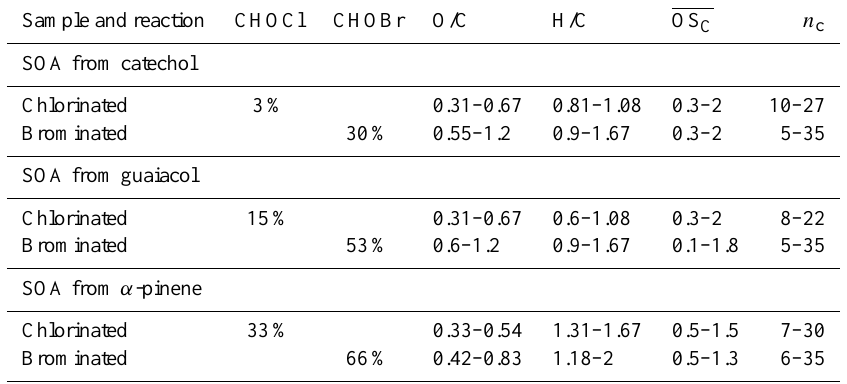
Table 2. Relative amount of halogenated compounds (compared to the not halogenated bulk) and basic aerosol parameters like O/C and H/C ratios as well as the averaged carbon oxidation state OS C (where n c is the related number of carbon atoms) observed in samples from the molecular photochemical reaction experiments (derived by ICR-FT/MS).